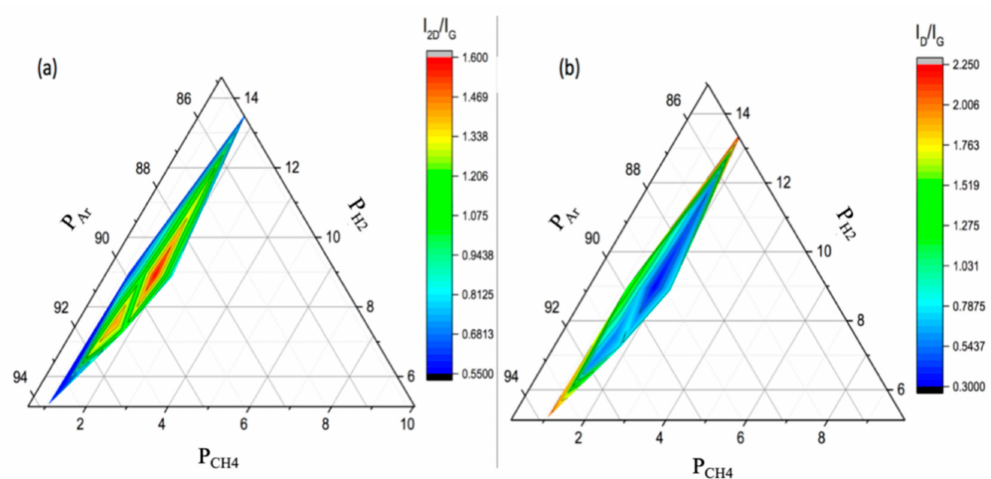
Figure 4. Ternary plots showing Raman intensity ratios as a function of gas partial pressures (P H2 , P Ar and P CH4 ), ( a ) I 2D / I G and ( b ) I D / I G (All axes are normalised with respect to total gas